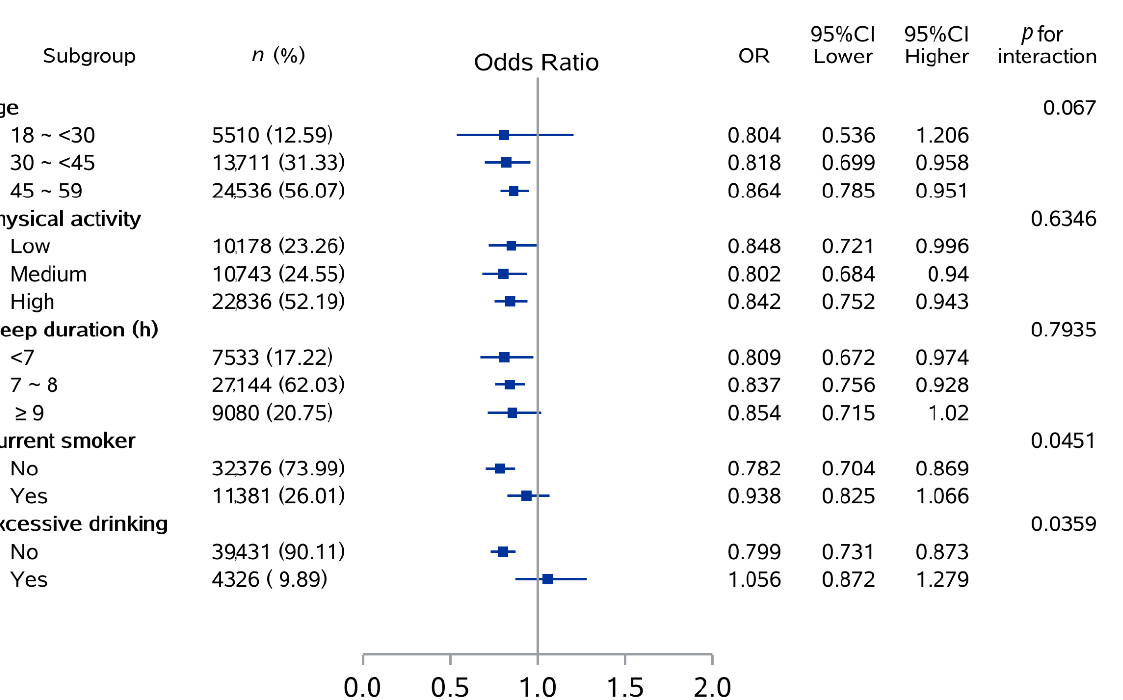
Figure 2. Subgroup analysis between habitual tea consumption and MetS according to potential risk factors.